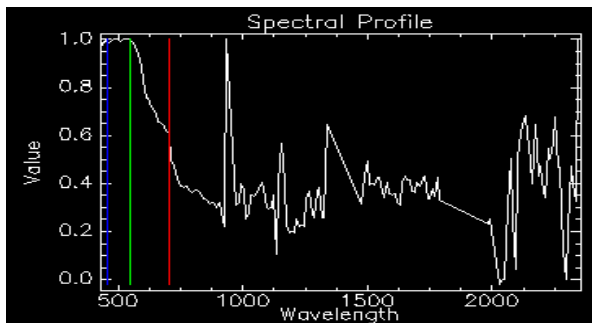
Figure 4. Spectral Profile of Water with radiance